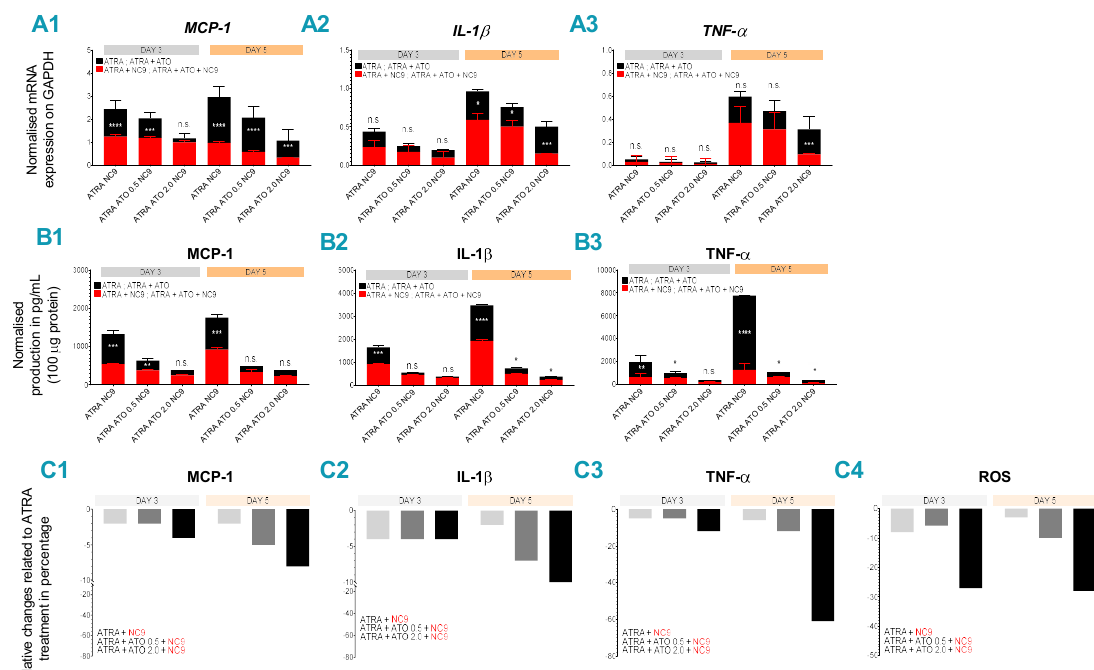
Figure 5. Inhibition of TG2 decreases the gene expression and the protein secretion of TNF- α , IL-1 β and MCP-1 in di ff erentiated NB4 cells. Relative mRNA expressions of MCP-1 ( A1 ), IL-1 β ( A2 ) and TNF- α ( A3 ) were measured in ATRA and in ATRA + ATO (0.5 or 2.0 µ M) in di ff erentiated NB4 cell lines with or without 30 µ M NC9 (red bars, black bars as control) on the indicated days by Q-PCR and were normalized to GAPDH. The mRNA expression levels from three independent experiments were measured in triplicate, and the graphs show the representation of the mean ± SD values. Statistical significance was determined via two-way analysis of variance (ANOVA; Bonferroni and Tukey post-hoc test; ATRA vs. ATRA + NC9 * p < 0.05, ** p < 0.01 and *** p < 0.001, **** p < 0.0001). The protein content of the supernatants of MCP-1 ( B1 ), IL-1 β ( B2 ) and TNF α ( B3 ) with or without 30 µ M NC9 (red bars, black bars as control) were quantified by ELISA and were normalized to 100 µ g protein content of NB4 WT cell lysates. The figures show secreted protein levels from three independent experiments measured in triplicate, and the graphs show the representation of the mean ± SD values. Statistical significance was determined via two-way analysis of variance (ANOVA; Bonferroni and Tukey post-hoc test; ATRA vs. ATRA + NC9 * p < 0.05, ** p < 0.01 and *** p < 0.001, **** p < 0.0001). Relative changes of MCP-1 ( C1 ), IL-1 β ( C2 ), TNF α ( C3 ) and ROS ( C4 ) production in the presence of NC9 related to ATRA-only treatment in NB4 WT cells. Changes were calculated from values of ATRA only and ATRA + NC9, from ATRA + ATO 0.5 µ M + NC9 and from ATRA + ATO 2.0 µ M NC9 treatments. Graphs represent the changes compared to a single ATRA